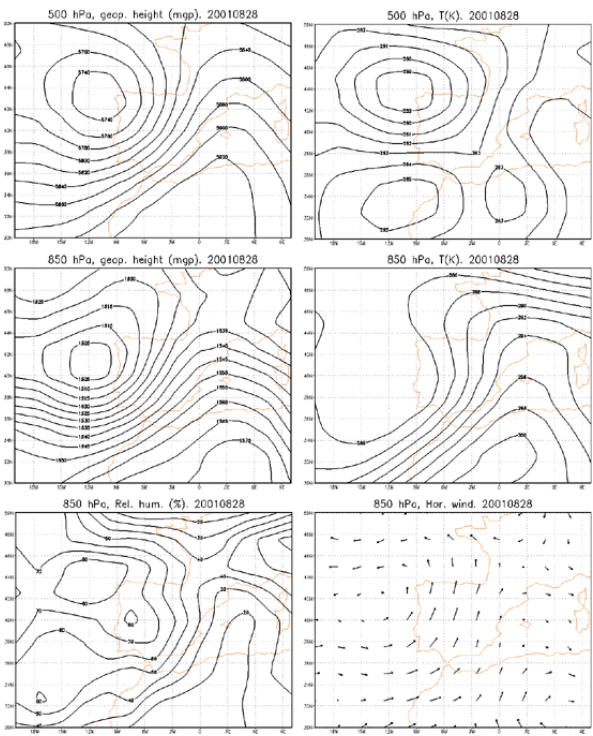
Fig. 4. NCEP reanalysis, 12:00UTC. Date: 28 August 2001, CL1. The atmospheric fields shown are: φ 500 (gpm), T 500 (K), φ 850 (gpm), T 850 (K), rh 850 (%) and wind direction at 850hPa, from left to right.